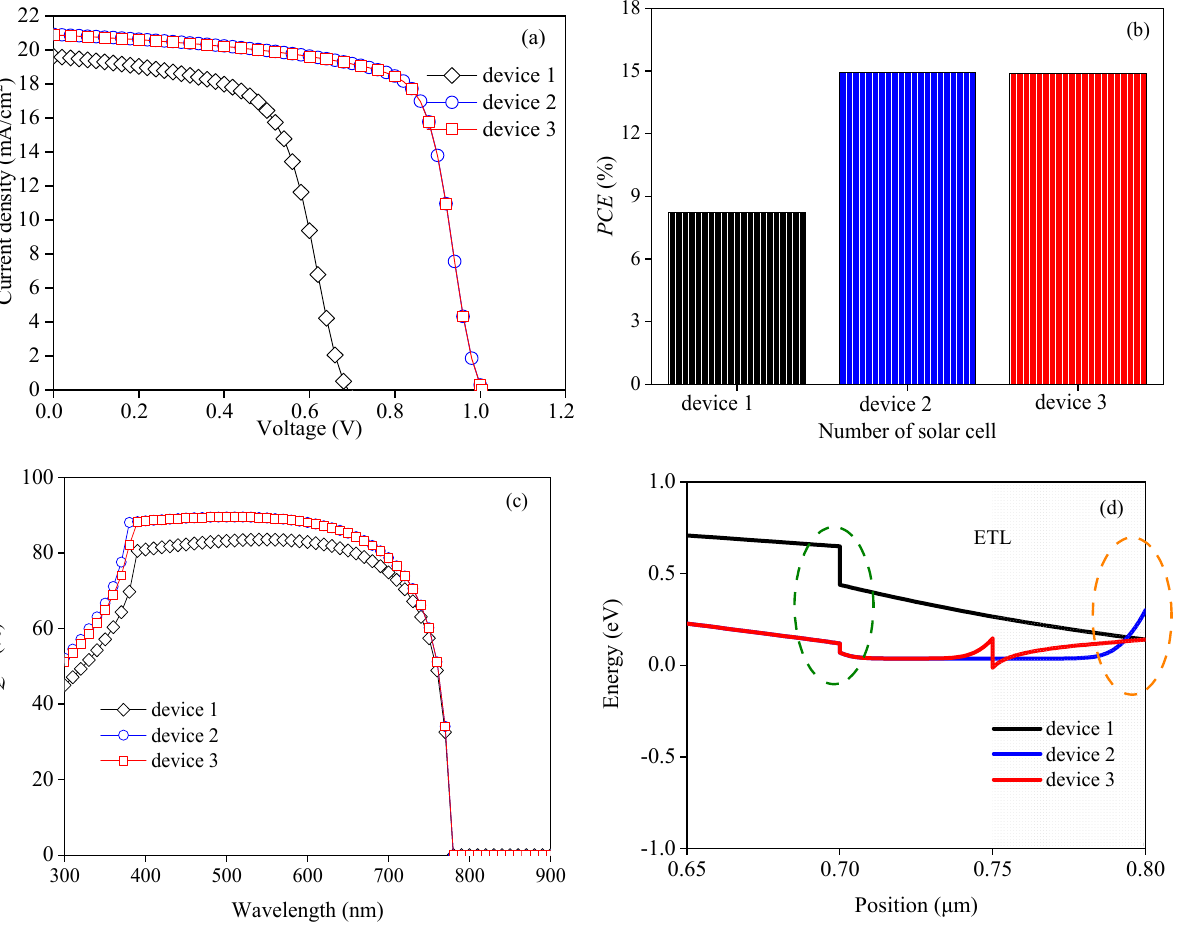
Figure 3. Performance comparison of three initial models: ( a ) J-V characteristic curves of three initial models, ( b ) PCE of three initial models, ( c ) quantum efficiency (QE) of three initial models, and ( d ) conduction band of device. (the area circled by the green dotted line represents the interface energy band shift between the ETL and perovskite active layer, and the area circled by the orange dotted line represents the barrier formed between the ETL and the cathode).